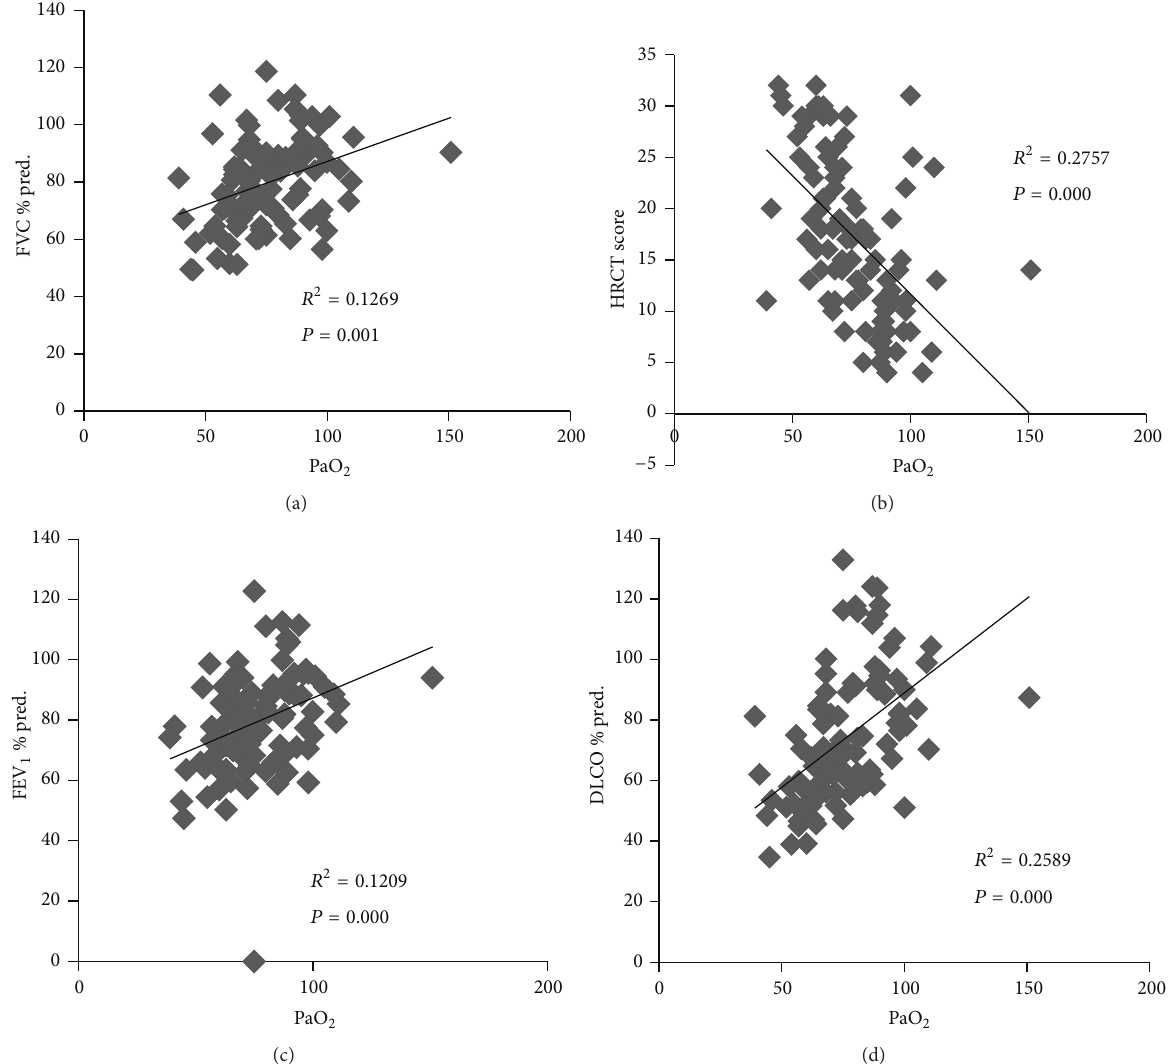
Figure 2: (a) Scatter diagram of PaO 2 with HRCT score. (b) Scatter diagram of PaO 2 with FVC, % predicted. (c) Scatter diagram of PaO 2 with FEV 1 , % predicted. (d) Scatter diagram of PaO 2 with DLCO, % predicted.